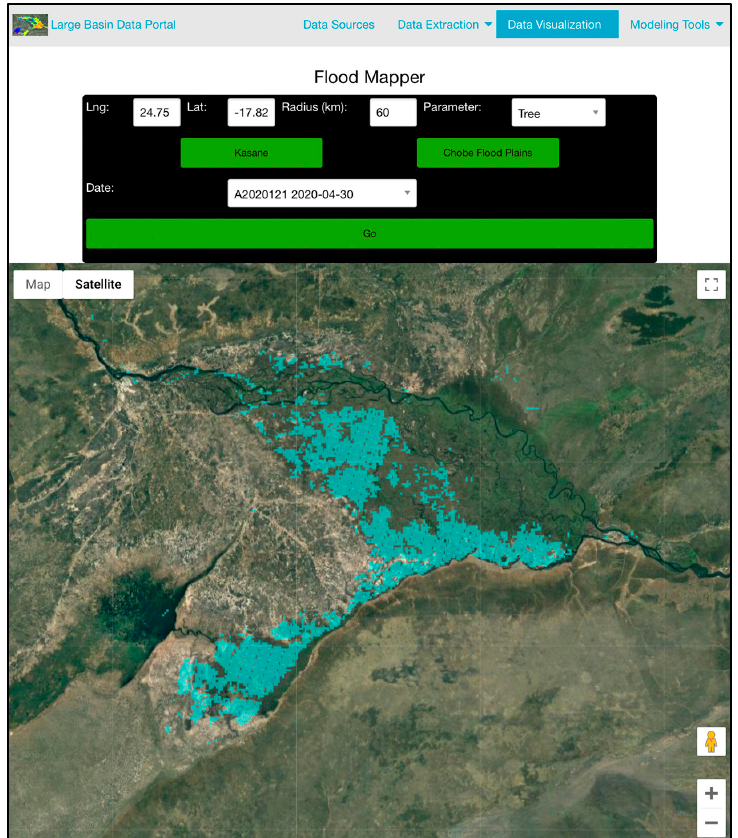
Figure 7. Screenshot of the Large Basin Data Portal flood mapper with input parameters and the dis- played map of the Chobe–Zambezi floodplains, Africa. The blue overlay reflects the presence of sur-